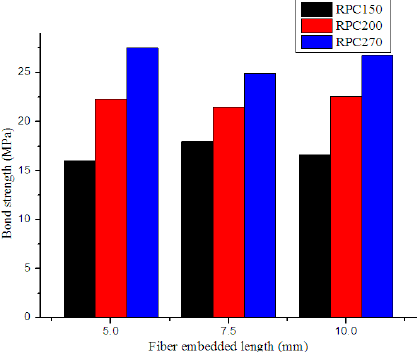
Figure 11. Effects of embedded fiber length on bond strength.